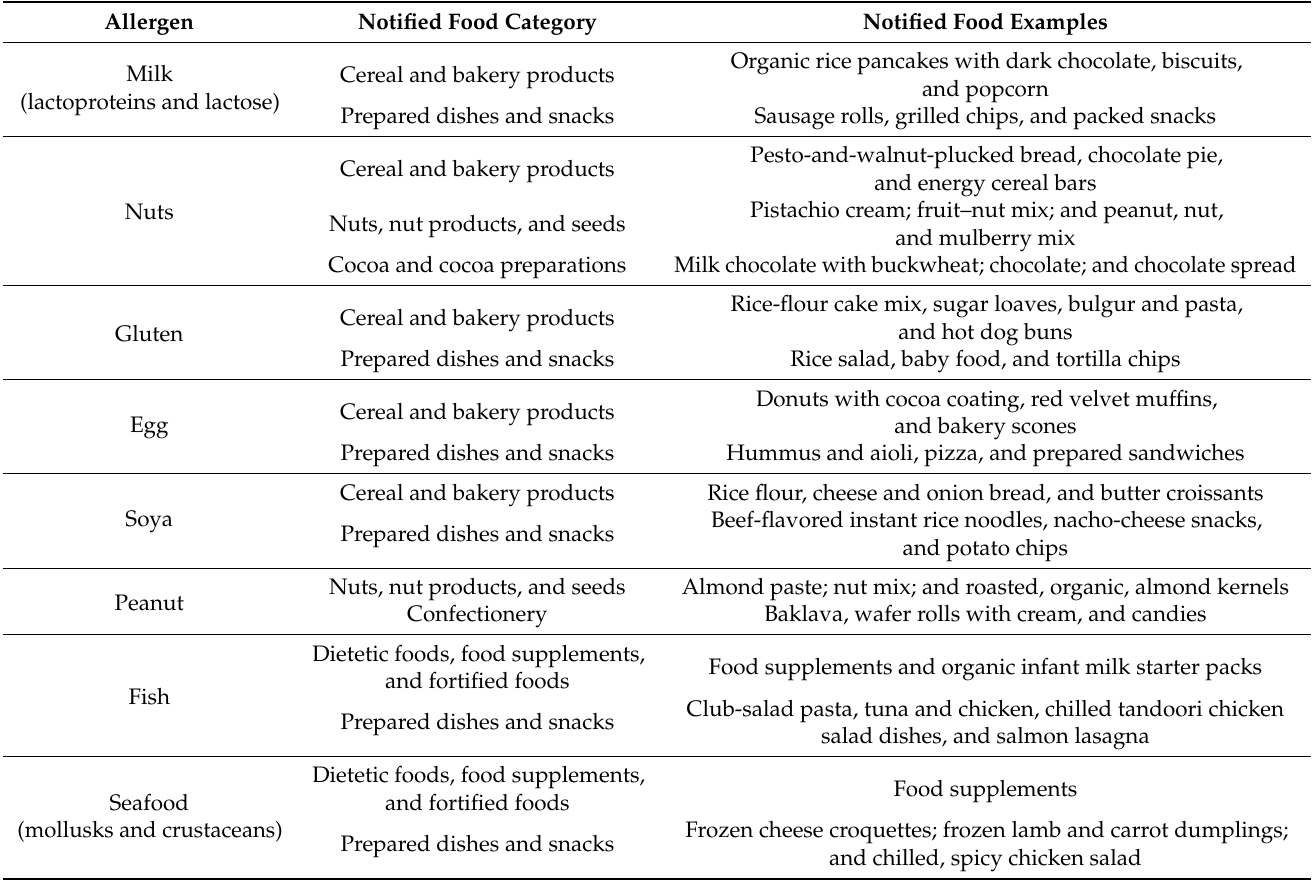
Table 5. Summary of the main allergens that affect the pediatric population, and main risk food category.